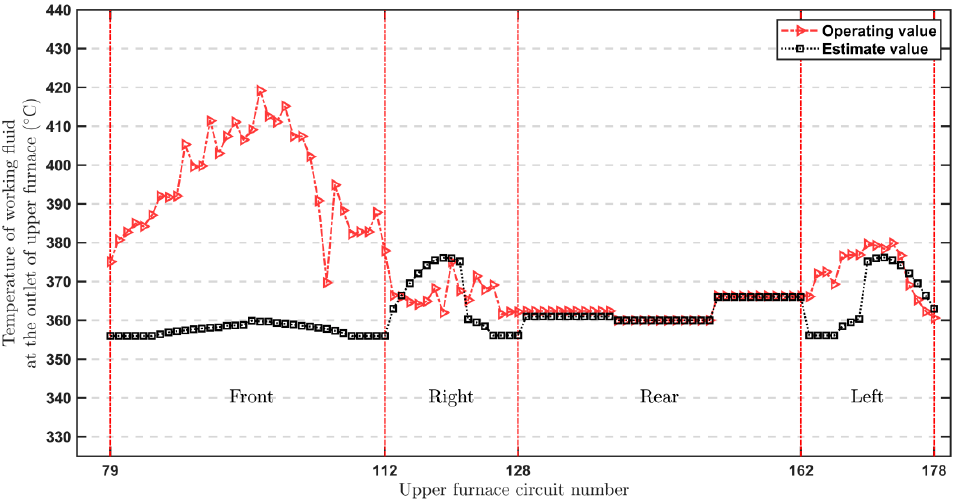
Figure 13. Comparison between calculated value of working medium temperature at outlet of upper furnace loop and field operation value.